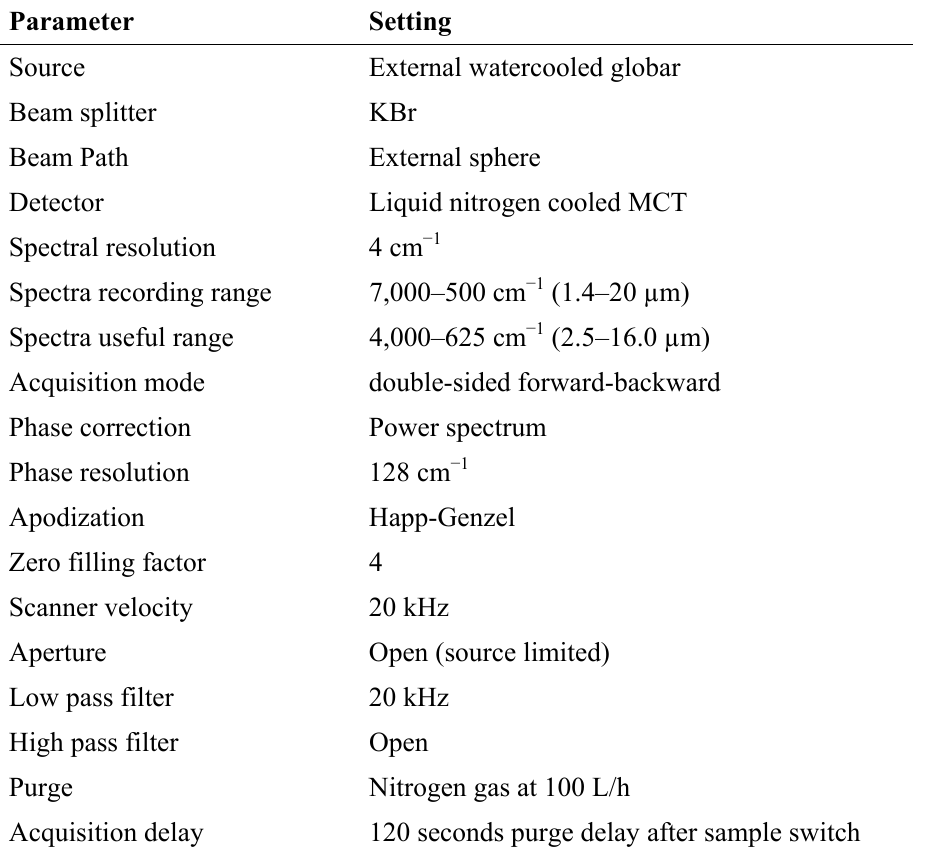
Table 2. Extended measurement